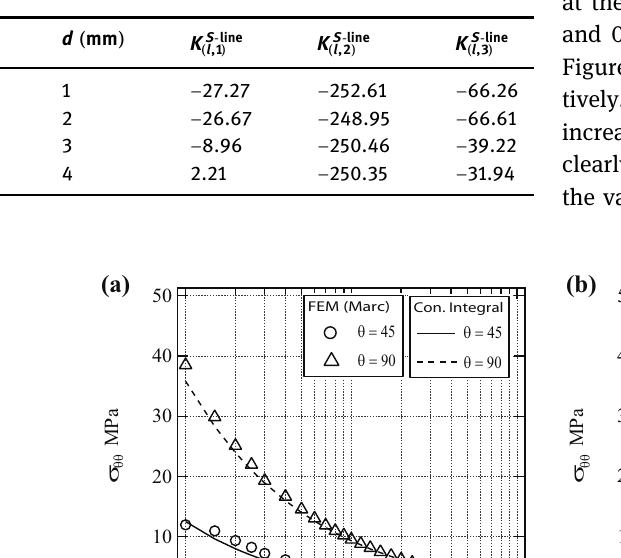
Table 6: The intensities of singularities along the side - line, ( ) - K l nS line ,